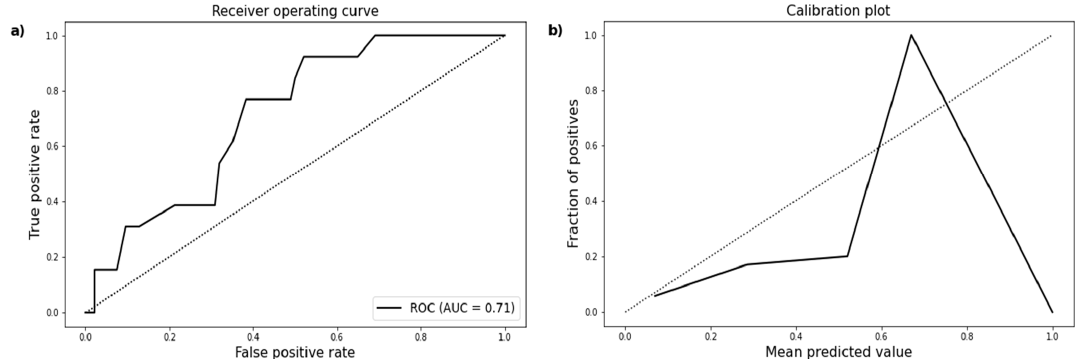
Figure 3. ( a ) ROC curve demonstrating an AUC of 0.71 (95% CI 0.58–0.83) for predicted sepsis. ( b ) Calibration plot showing the distribution of observed sepsis and the corresponding prediction.